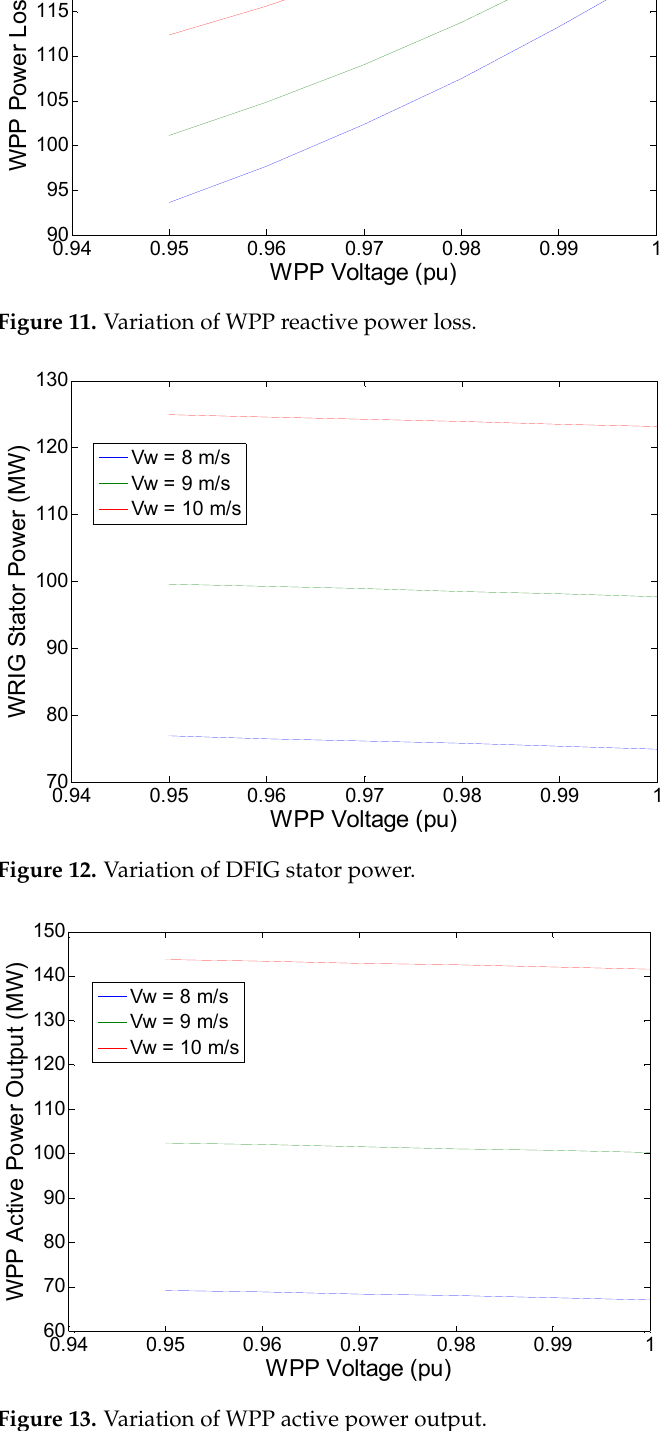
Figure 13. Variation of WPP active power output.